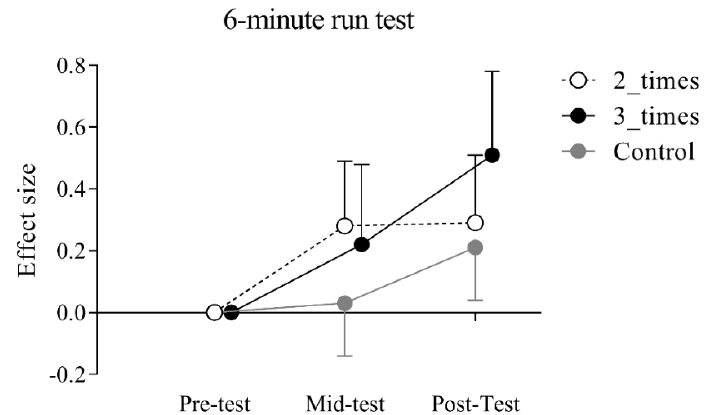
Figure 1. Mean effect size and 95% confidence interval (CI) changes in cardiorespiratory fitness in the three different groups.